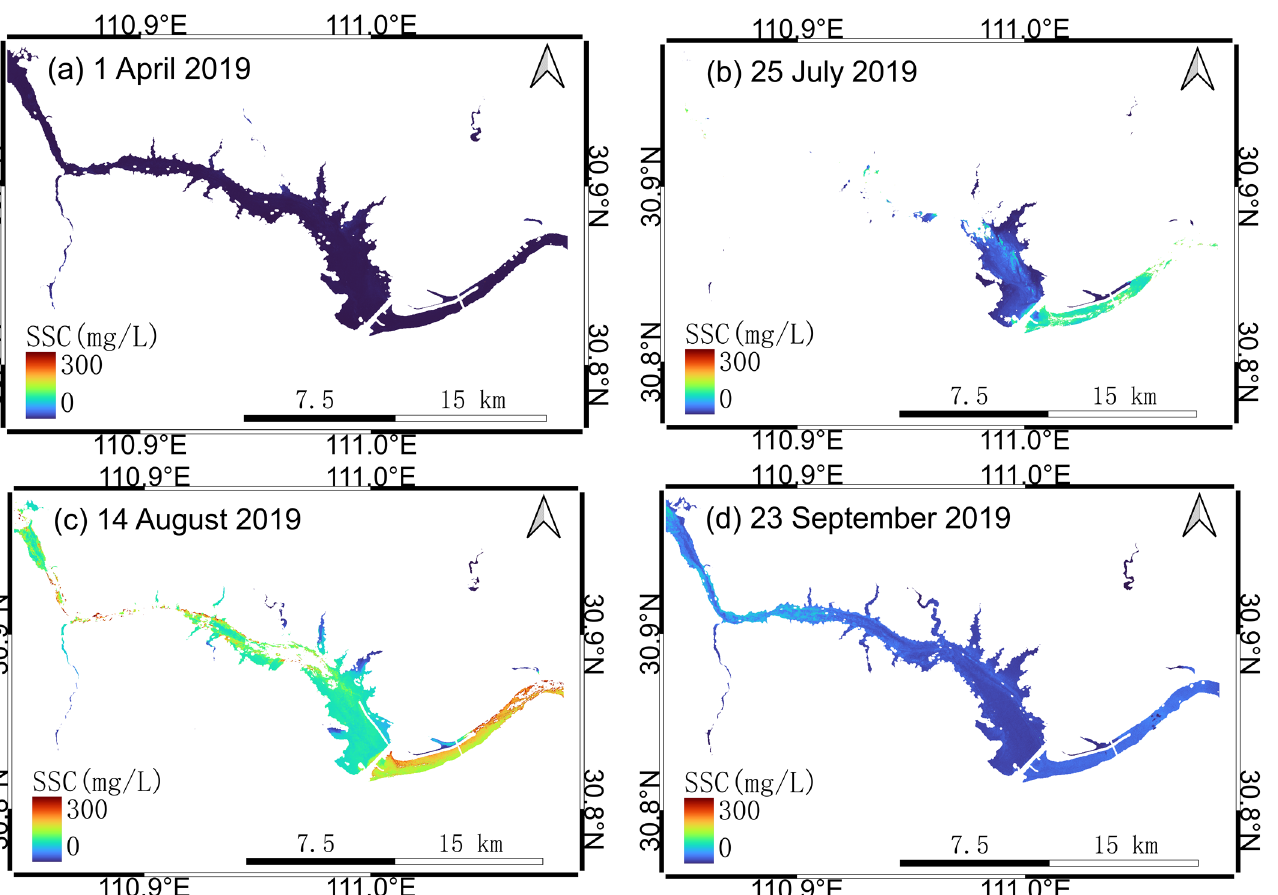
Figure 10. Spatiotemporal distributions of the retrieved SSC above and below the Yibin Reach. The expanded views in the red rectangles indicate the clear dividing line at the confluence. The Senti-